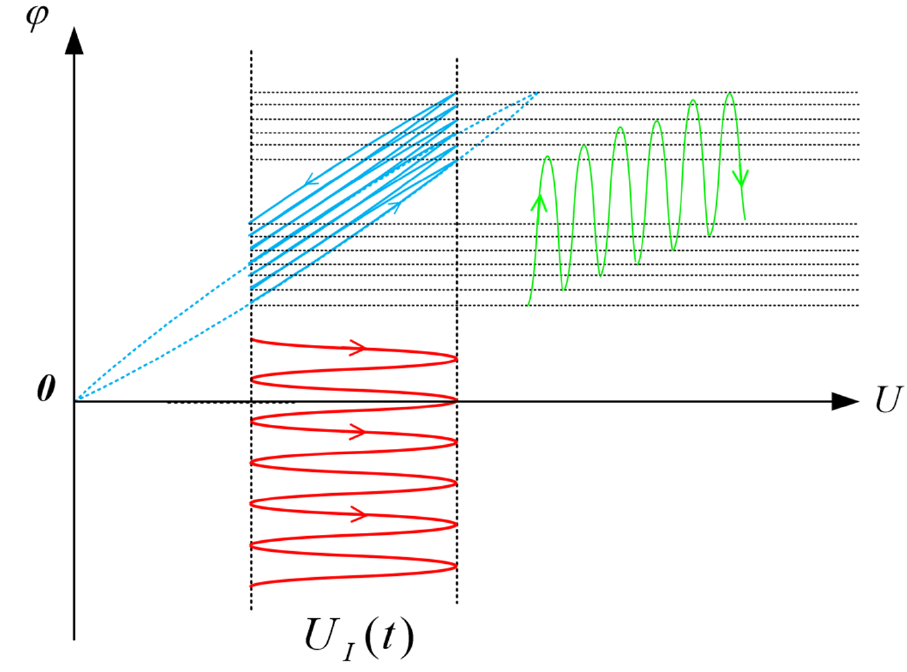
Figure 5. Modulation curve (phase drift) under hysteresis nonlinearity.